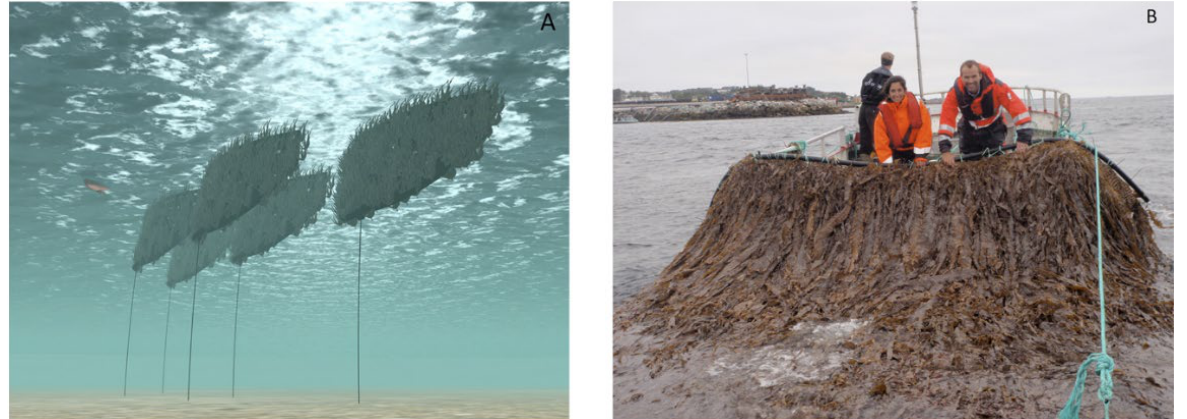
Figure 19. The Seaweed Carrier – Seaweed Energy Solutions AS—using a sheet-like net with single ca- ble mooring—system can be expanded with up to 20 sheet carriers on longline system per mooring. ( A ) Concept, ( B ) net at harvest, Reproduced with Permission [15].